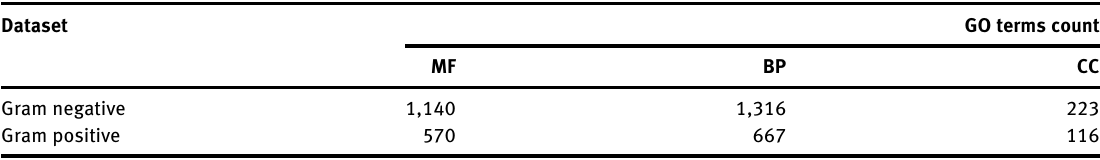
Table  : Extracted GO terms statistics for the three components of GO namespace, namely, Molecular Function (MF), Biological Process (BP), and Celullar Component